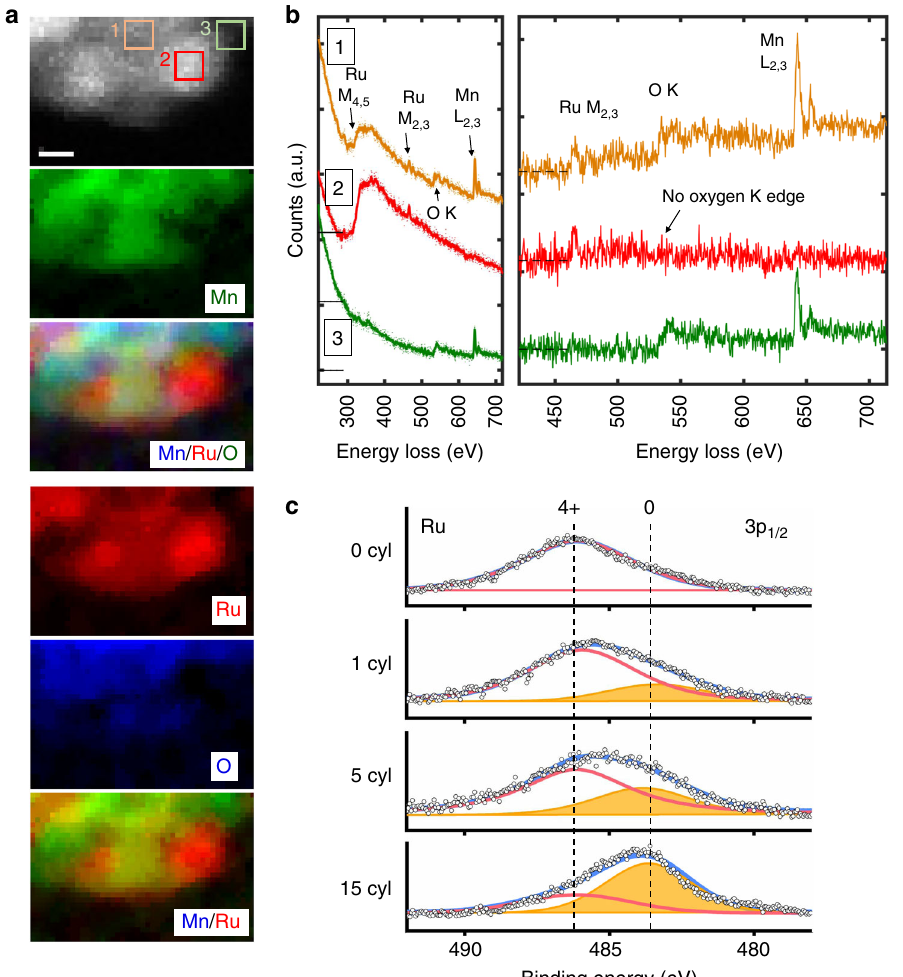
Fig. 4 Revealing the surface chemistry by electron energy loss spectroscopy (EELS) and X-ray photoemission spectroscopy (XPS). a STEM-EELS mapping of the Mn, Ru, and O in the near-surface area of a LRMO particle after 15 charge cycles. The Ru and O maps show that cluster on the right is nearly pure Ru without oxygen. b The EELS spectra integrated from area 1, 2, and 3 in a . c The Ru 3p 1/2 core-level XPS spectra of the LRMO cathode surface as a function of charge/discharge cycles. The Ru 4 + composition decreases and the Ru 0 composition increases as the cathode undergoes more cycles. (Scale bar: 1